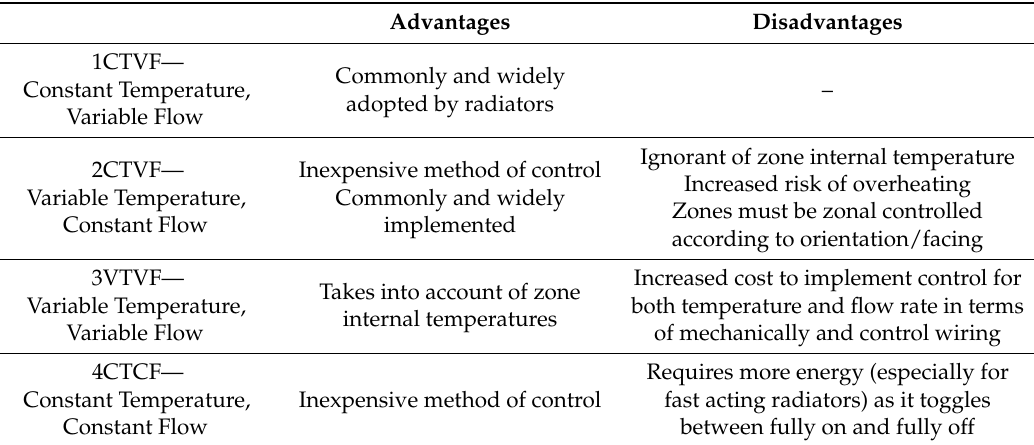
Table 5. Comparison between various methods of